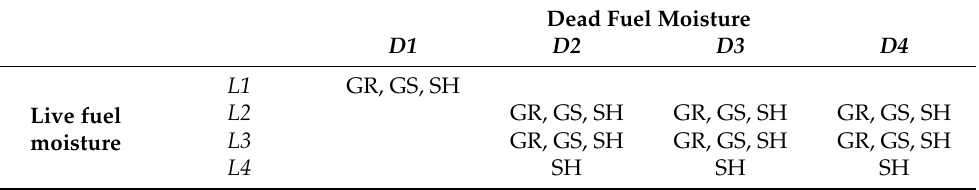
Table 3. Moisture scenarios used.